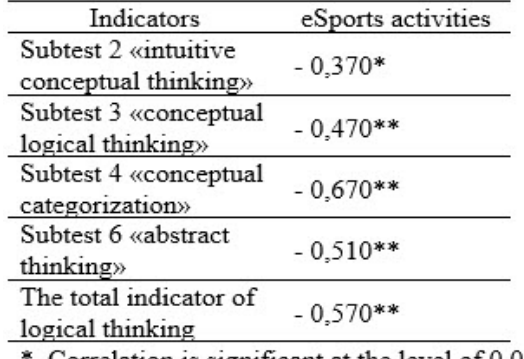
Table 2. Correlation analysis of eSports activities and indicators of logical thinking